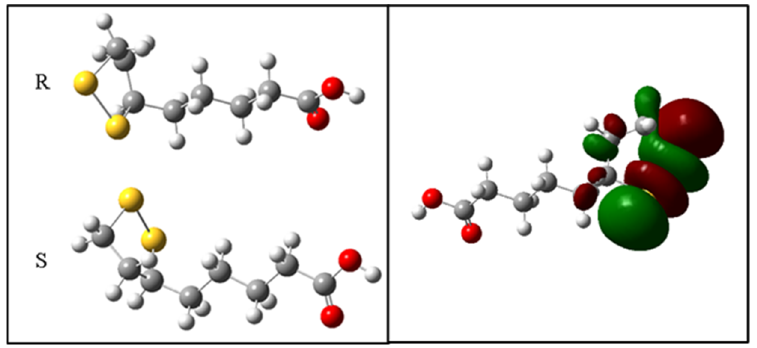
Figure 8. Electronic density of the boundary orbitals of the R ‐ ALA and S ‐ ALA isomers.